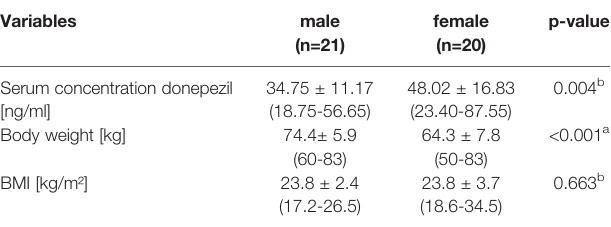
TABLE 3 | Sex differences donepezil : Serum concentration and BMI of male and female participants, respectively, in the donepezil group. Variables